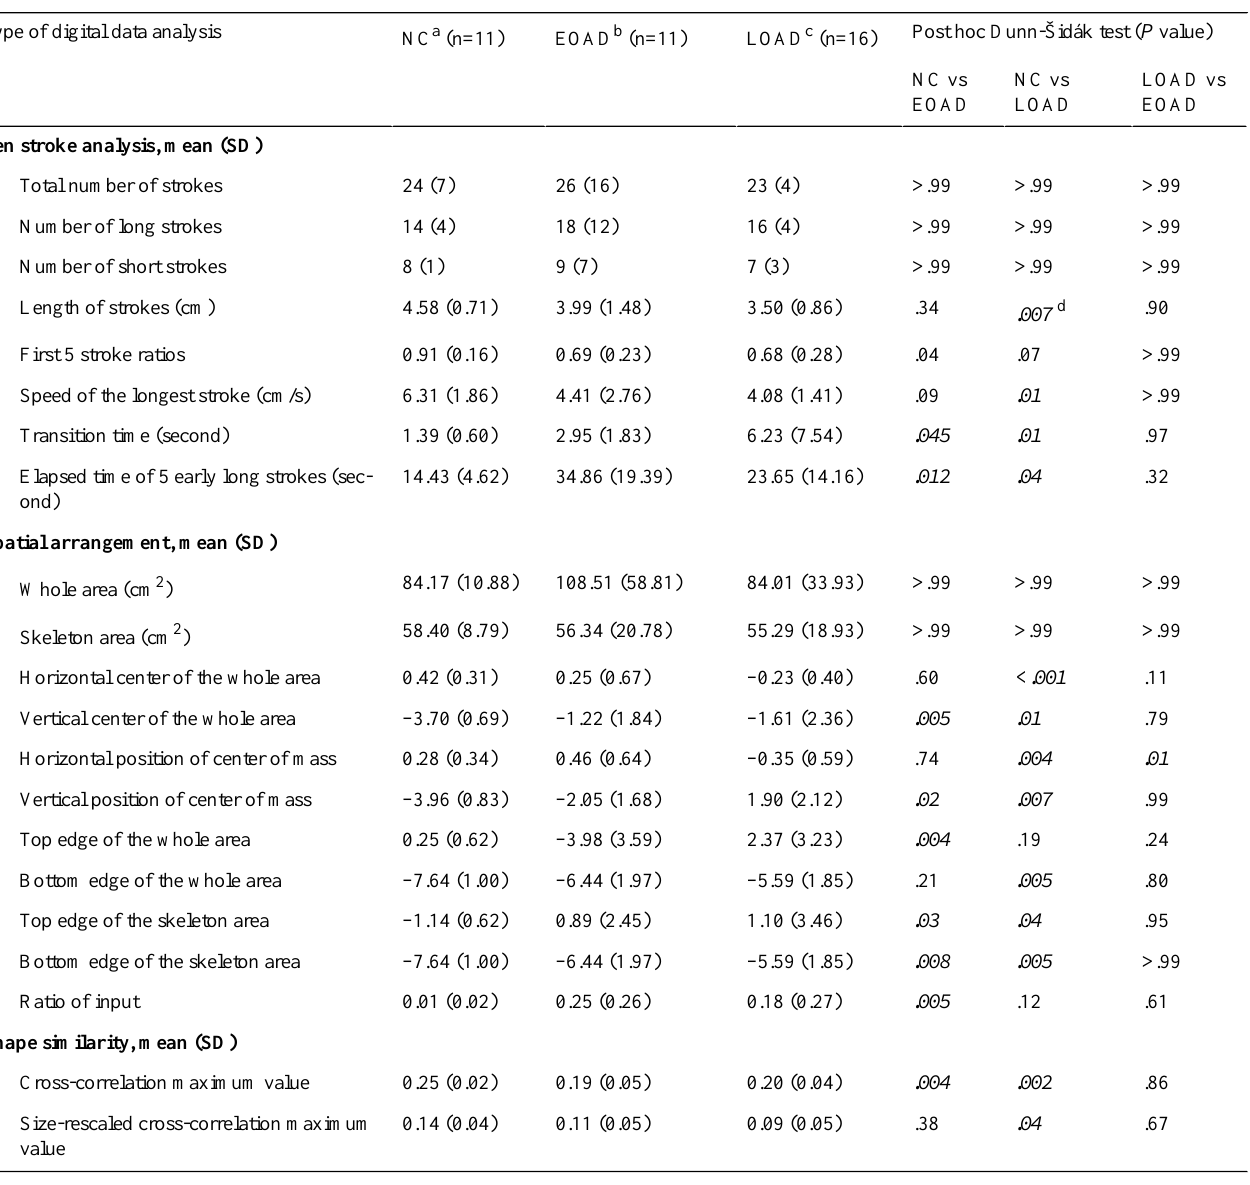
Table 3. Digital data of simplified Rey-Osterrieth Complex Figure